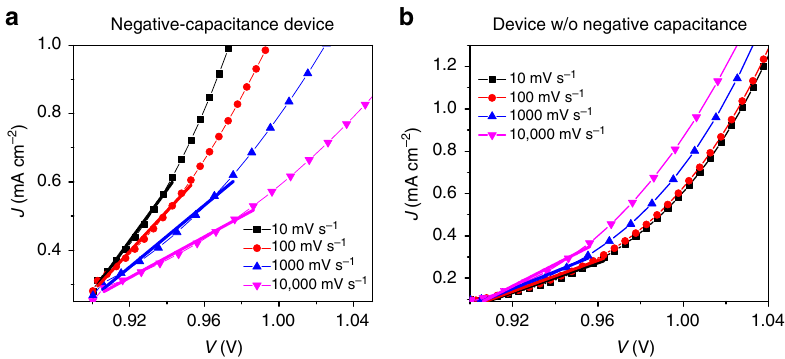
Fig. 6 JV curves in the dark for different scan rates after equilibration at 0.9 V. a Negative-capacitance device, b Device without negative capacitance. The differential resistance is indicated by the lines. The trends in the resistance with scan rate are opposite between the two directly obvious that R low f is correlated with R high f — an observation also reported in ref. 22 and in that study related to surface recombination. Following R high f , the R low f decreases by orders of magnitude when the voltage is increased analogous to a